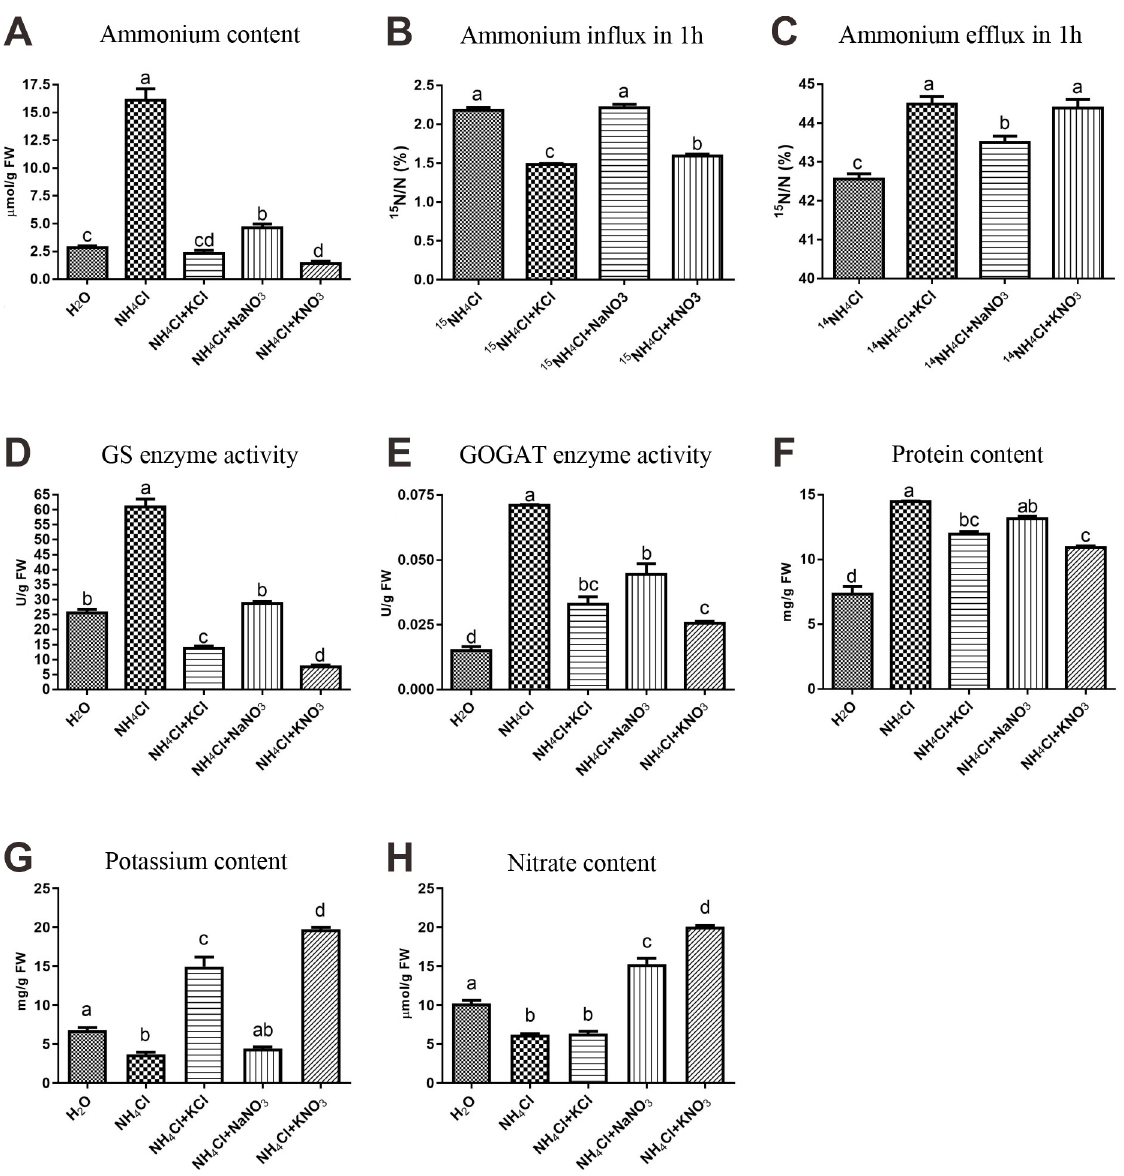
Fig 4. Composition, transport, and enzyme activity related to nitrogen status. (A) The ammonium concentrations. (B and C) For the 15 NH 4+ transport assay, rice seedlings were grown for 7 days in 14 NH 15 NH 4 Cl (for B) or 4 Cl (for C) solution containing no other substance and then transferred to solutions containing 15 NH 4 Cl (for B) or 14 NH 4 Cl (for C) with the 3 alleviation treatments for 1 hour (see Materials and methods) before the root 15 N content was measured. (D-H) Data are mean ± SD; t-tests were used to identify significant differences, and different letters represent significant differences among different treatments (p <